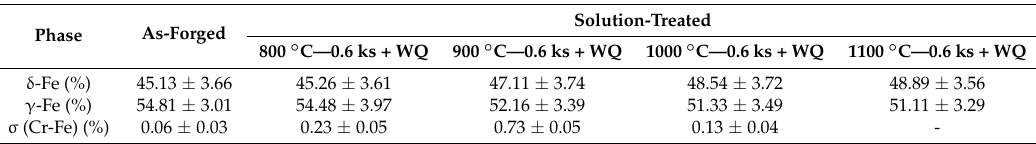
Table 1. Computed weight fractions of observed phases for all investigated microstructural states. WQ means water-quenching.